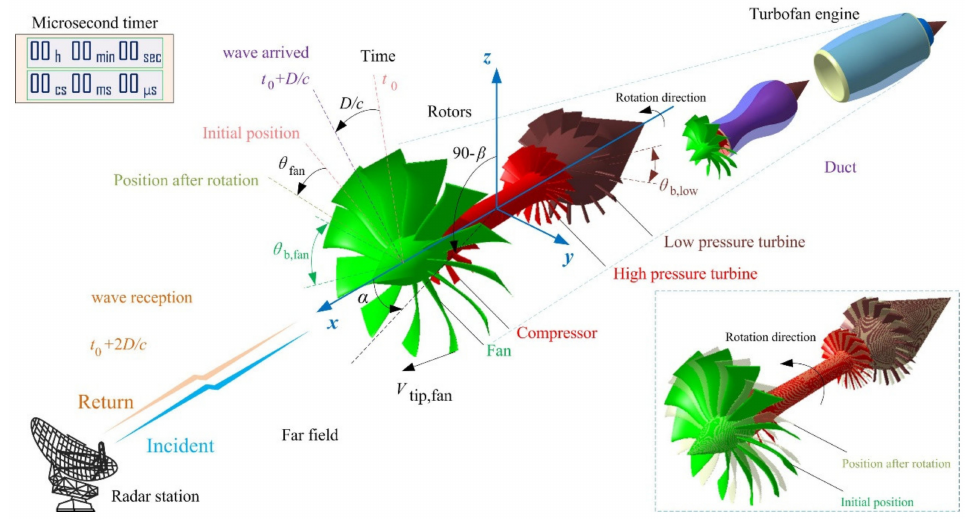
Figure 1. Schematic diagram of dynamic electromagnetic scattering of a biaxial turbofan